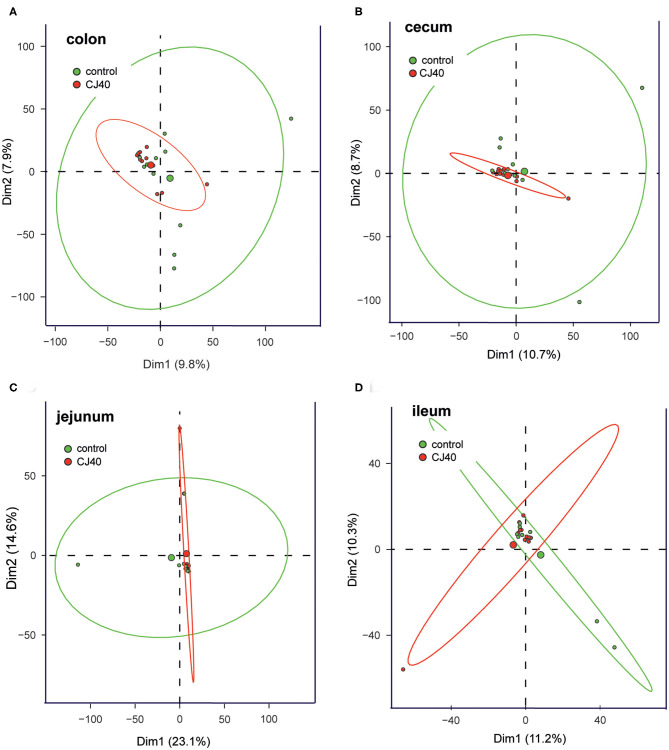
PCA of the effects of the diet containing 40% yeast protein on the relative abundances of microbial communities in (A) cecum, (B) ileum, (C) jejunum, and (D) colon samples. The ellipsoids represent confidence intervals (p ≥ 95%) and the centroids represent medians for the respective groups of samples. n = 12 per group.